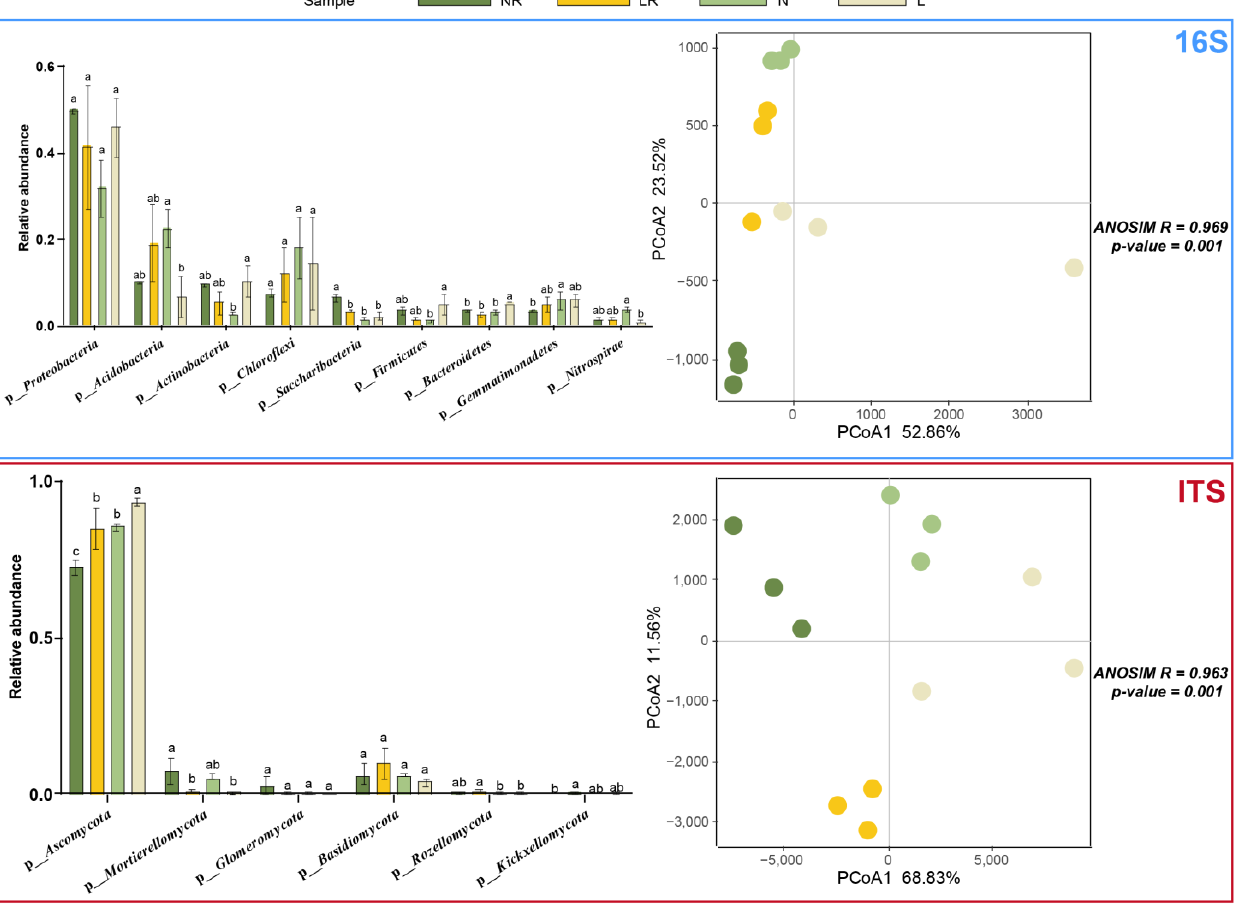
Figure 4. The relative abundance of the top bacterial (16S) and fungal (ITS) phyla and principal co-ordinates analysis in the rhizosphere and bulk soil of highbush blueberry plants with normal or limited growth. NR-rhizosphere soil of normally growing plants; LR-rhizosphere soil of plants with limited growth; N-bulk soil of normally growing plants; L-bulk soil of plants with limited growth. Different lower-case letters indicate significant differences ( p ≤ 0.05).